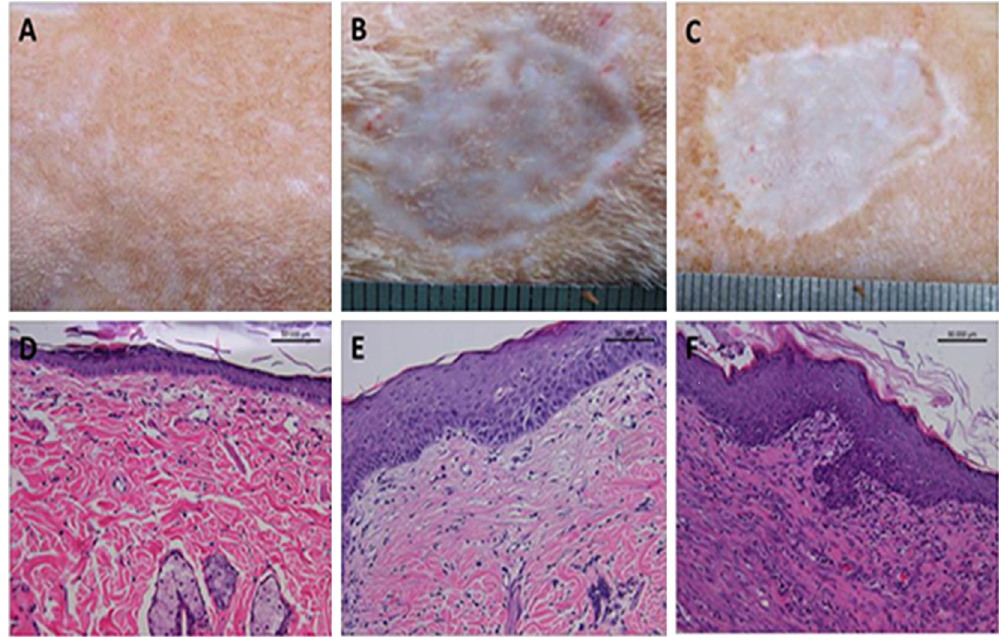
Figure 9. Gross views ( A – C ) and H&E staining of sections ( D – F ) of normal skin ( A , D ) and wounds treated by NAg-CCS ( B , E ) and CCS ( C , F ) at day 60 post transplantation, respectively. Ultra-thin autografts were transplanted at day 10. The bar indicates 50 μ